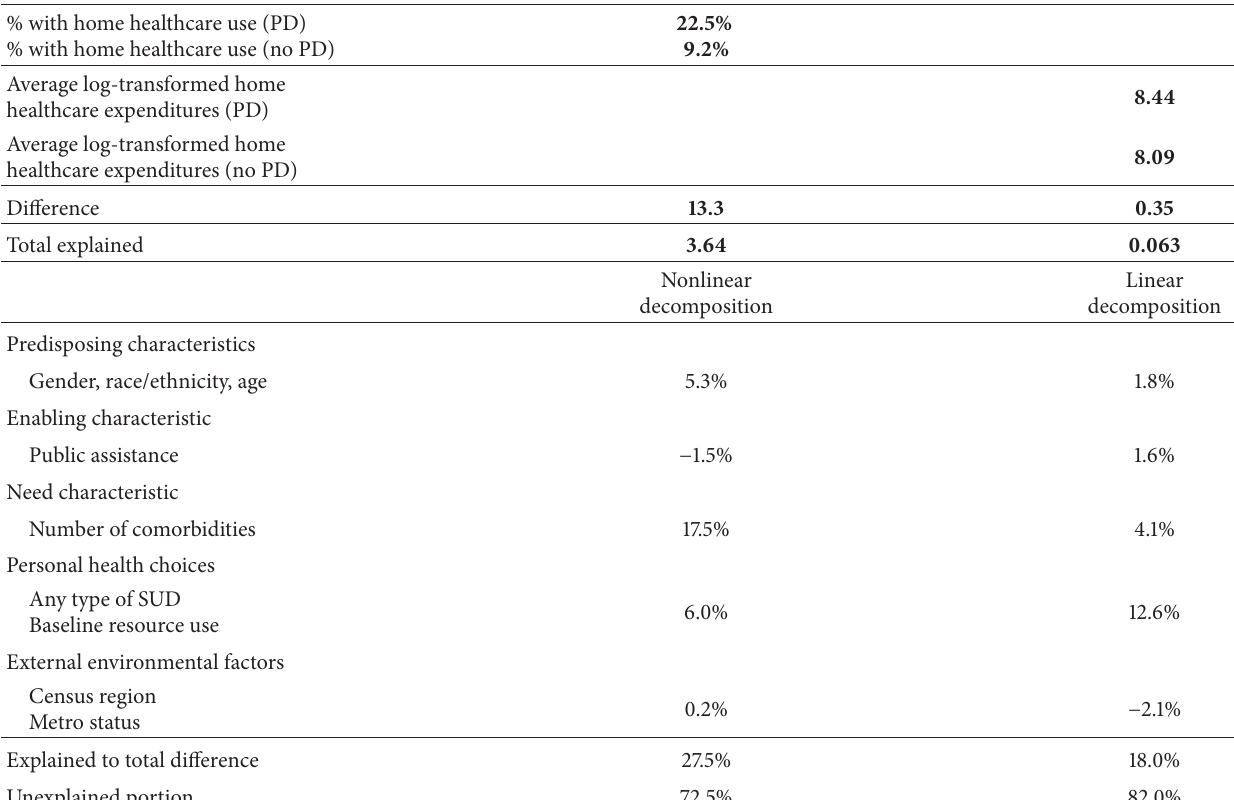
Table 4: Nonlinear and linear decomposition of home healthcare use and expenditures. Elderly Medicare beneficiaries with and without PD. Medicare 5% claims database (2006,